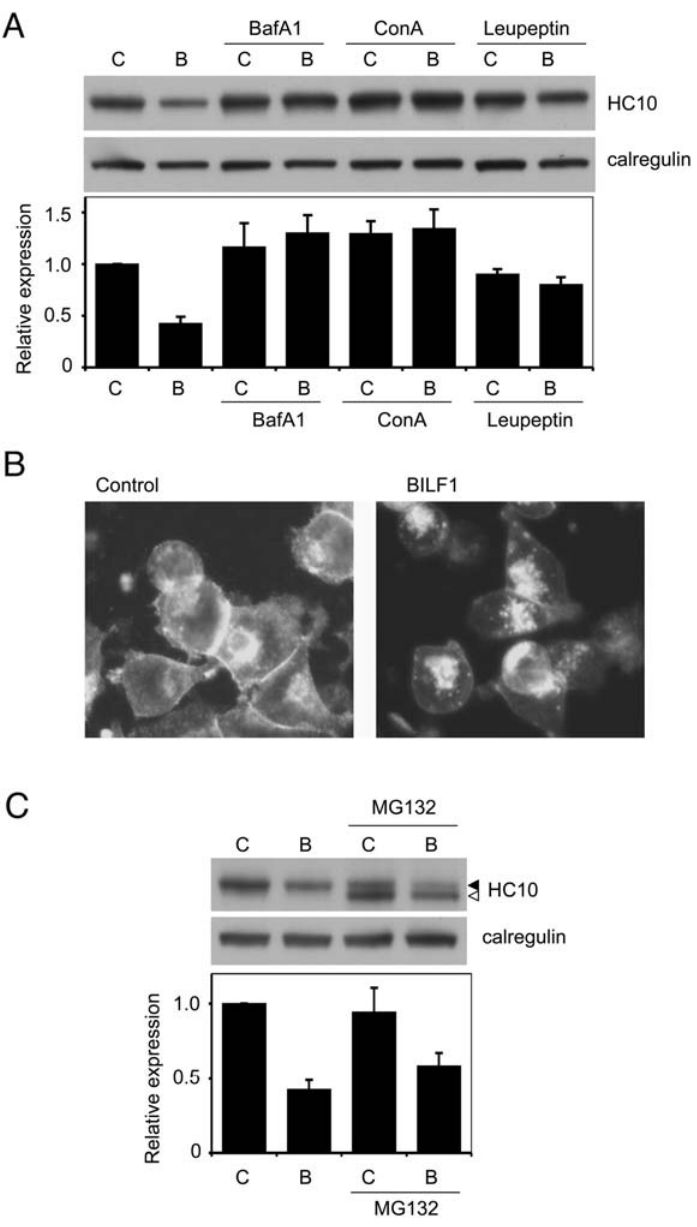
Figure 8. Lysosomal inhibitors block BILF1-enhanced degradation of MHC class I. ( A ) 293 cells stably transduced with control- ( C ) or BILF1- ( B ) retrovirus were treated with or without Bafilomycin A1, concanamycin A, or leupeptin for 20 hr. Lysates from 2 6 10 5 cell equivalents were separated by SDS/PAGE gel, and analyzed by western blotting using antibodies specific for MHC class I (HC10) and calregulin. The blot is one representative of three independent experiments. The histogram shows the mean results ( 6 S.D.) of quantification by densitometry of all the blots from 3 independent experiments, where the densities of the HC10 bands were normalized relative to their own calregulin loading control. ( B ) 293 cells stably transduced with control or BILF1 retrovirus were treated with concanamycin A (50 nM) for 6 hr prior to fixation and permeabilization with methanol/acetone, then stained with W6/32 primary antibodies and Alexa Fluor H 488 goat anti-mouse IgG secondary antibodies. The photographs were obtained with a conventional fluorescence microscope. ( C ) 293 cells stably transduced with control ( C ) or BILF1 ( B ) retrovirus were treated with or without the proteasome inhibitor, MG132, for 20 hr, and analyzed by western blot as in panel A. The additional, lower molecular weight species detected is probably deglycosylated and/or partially degraded free heavy chain that is normally targeted for proteasomal